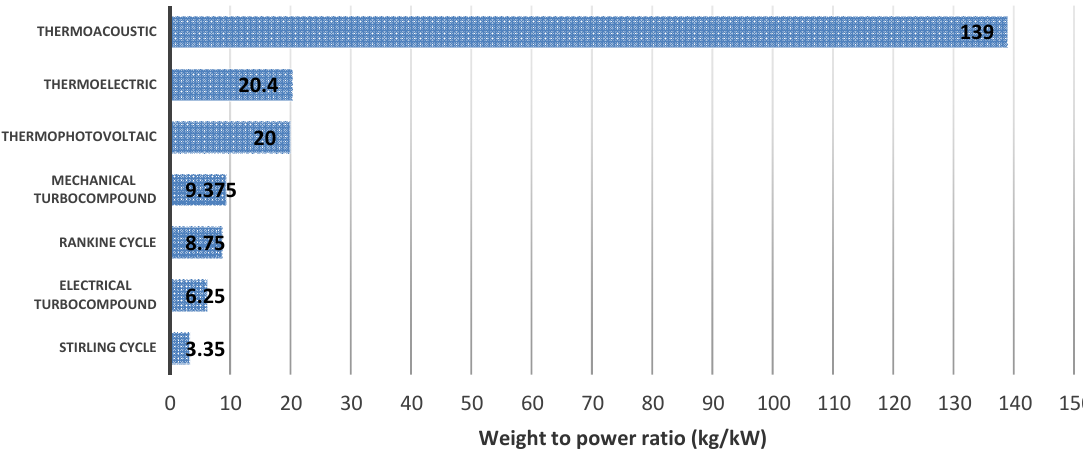
Figure 3. Weight to power ratio for different waste heat recovery technologies on a mobile application [15,27,30,33,39,40]. Adapted from